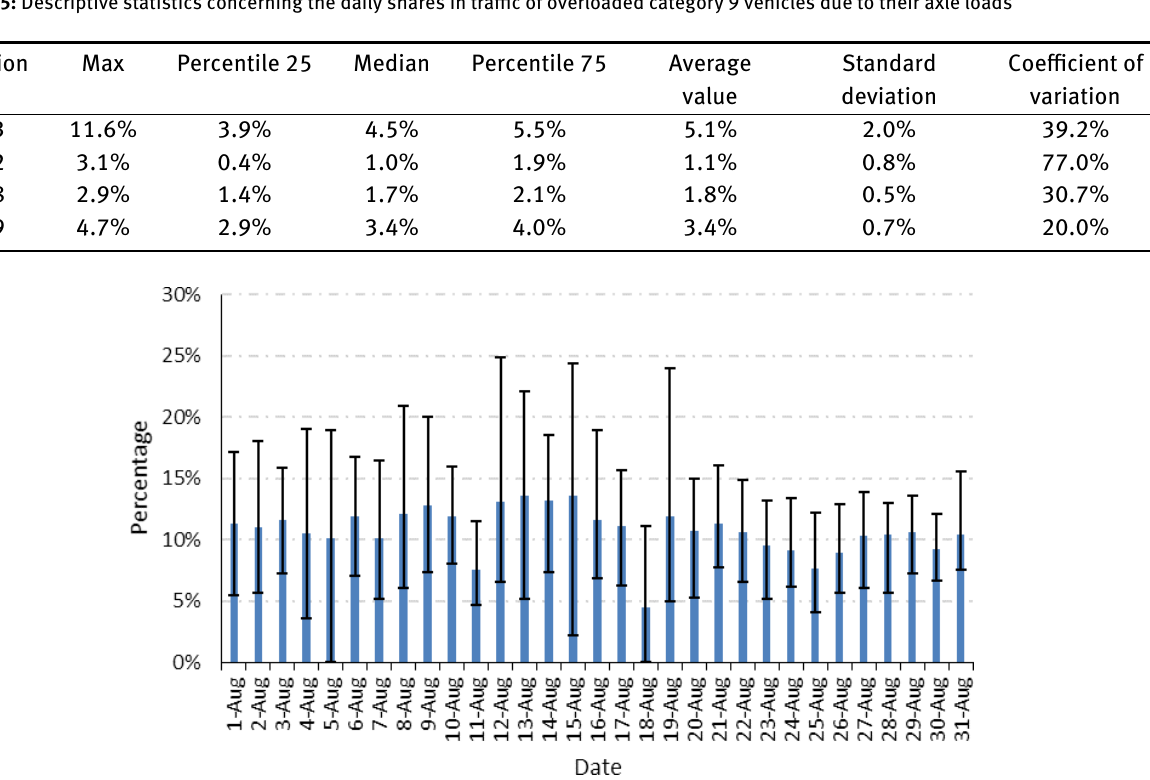
Table 5: Descriptive statistics concerning the daily shares in traflc of overloaded category 9 vehicles due to their axle loads